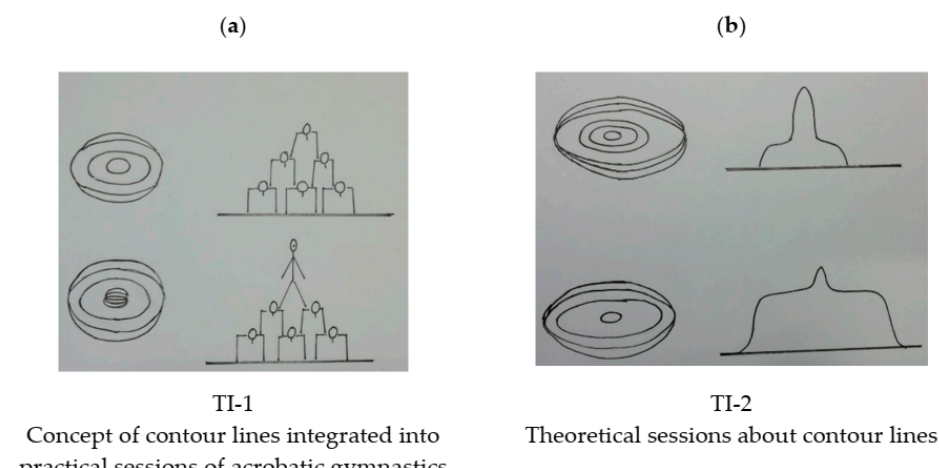
Figure 2. Selection of images shown to participants in TI-1 ( a ) and TI-2 ( b